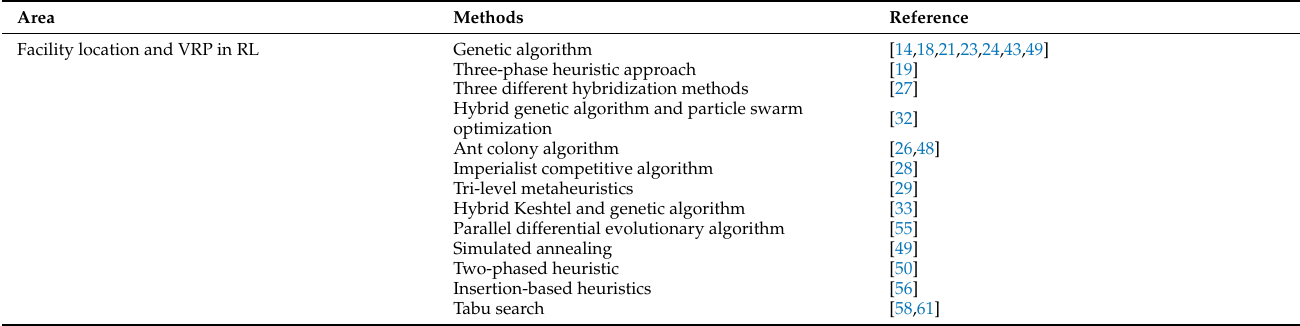
Table 6. Heuristic or metaheuristic